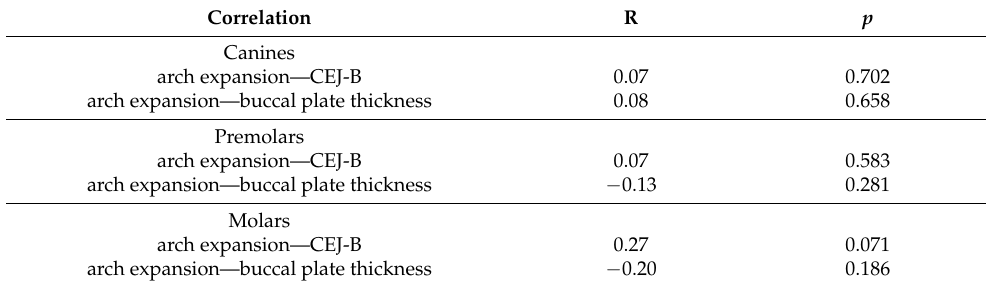
Table 9. The correlation between the arch expansion and CEJ-B and buccal bone thickness